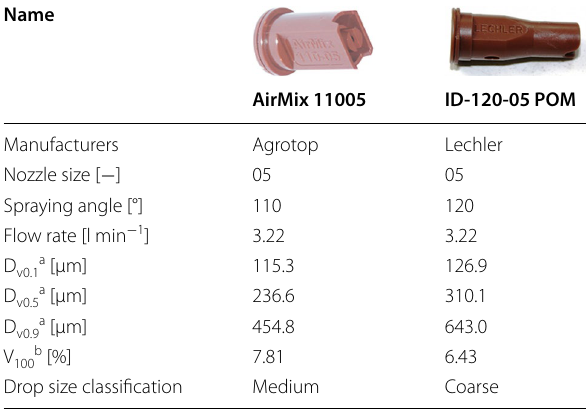
Table 1 Main parameters and the droplet size spectrum of the nozzles used in the